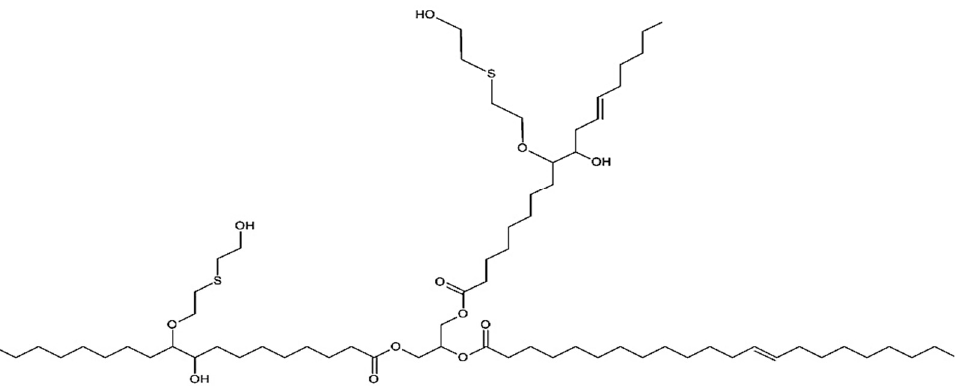
Figure 1. Schematic chemical structure of PG1 bio-polyol.